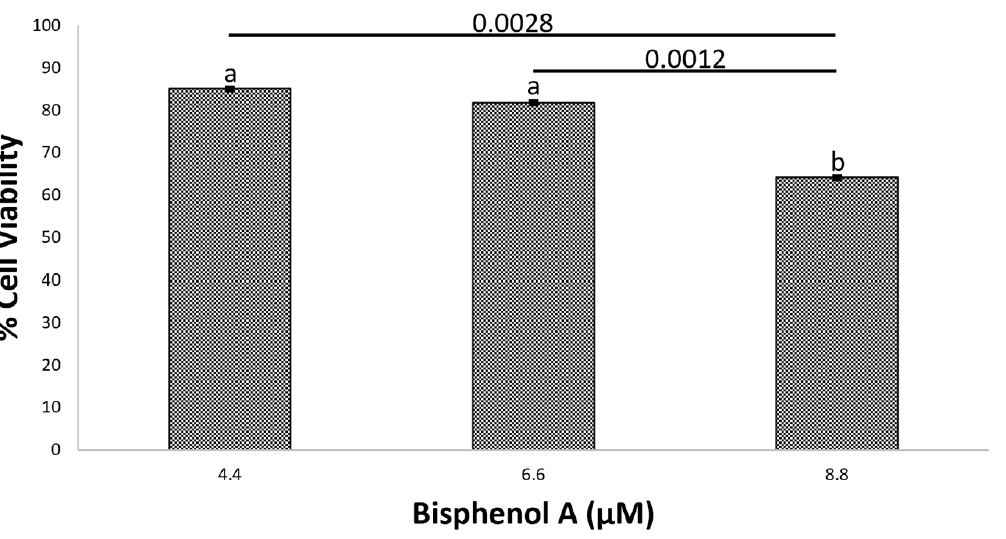
Figure 3. Effect of BPA on HT-29 cells after 48 h treatment. Each value represents the average of three independent experiments in triplicate ± ES. Different letters indicate significant difference ( p < 0.003) by Tukey ’ s test. BPA-treated cells were normalized to the negative control. The decrease in cell viability using a concentration of 8.8 µ M of BPA could be due to the toxic effect of BPA on the cell, leading to uncontrolled death, known as necrosis. Previous studies have reported the toxicity of BPA in cancer cells, including colon cells, when the concentration of the disruptor increases [27]. In this study, the FDA-approved tolerable dose of BPA (4.4 µ M) was used. At this concentration, cell viability decreased by approximately 10%. The process of cell necrosis will be discussed later based on the results of the lactate dehydrogenase assay. Simultaneous exposure of Q to BPA or FEQ to BPA resulted in a percent viability between 50 and 60%, which is very similar to the IC 50 of Q and FEQ individually (Figure 4).